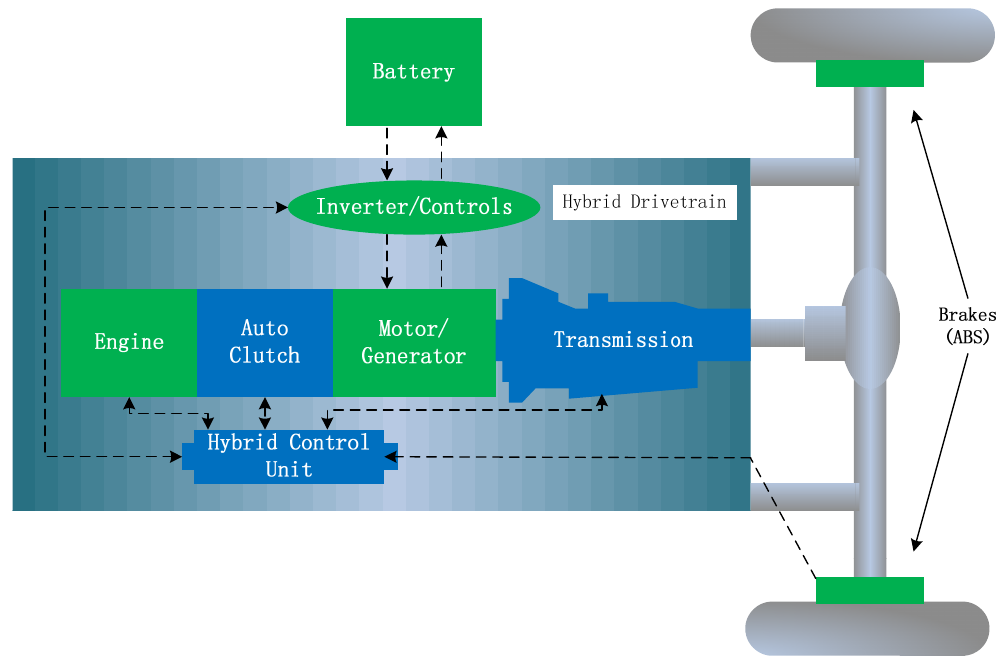
Figure 1. Schematic diagram of the parallel hybrid electric vehicle